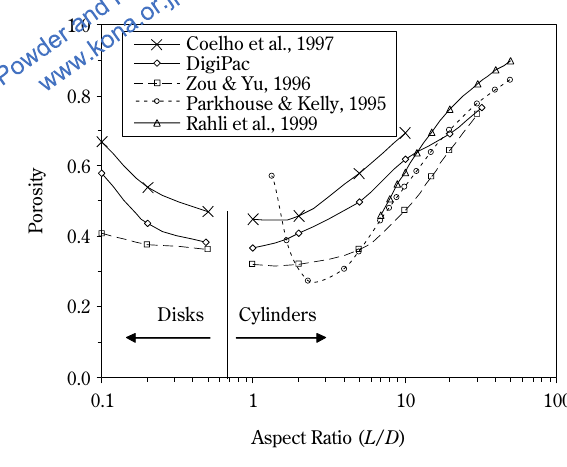
Fig. 5 Porosity versus aspect ratio for the packing of cylinders.